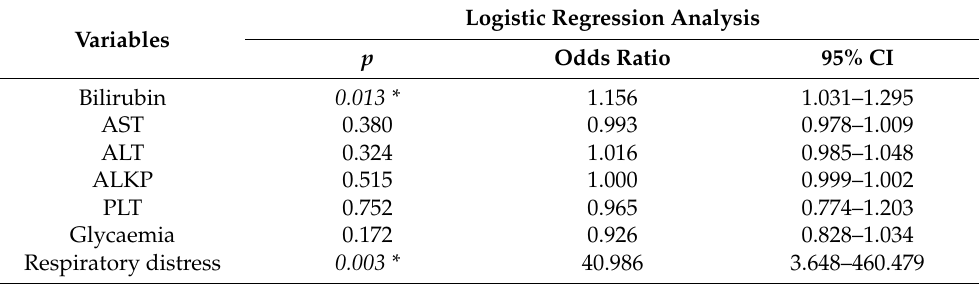
Table 2. Multivariate logistic regression analysis of clinical and laboratory variables associated with risk of pulmonary haemorrhage.